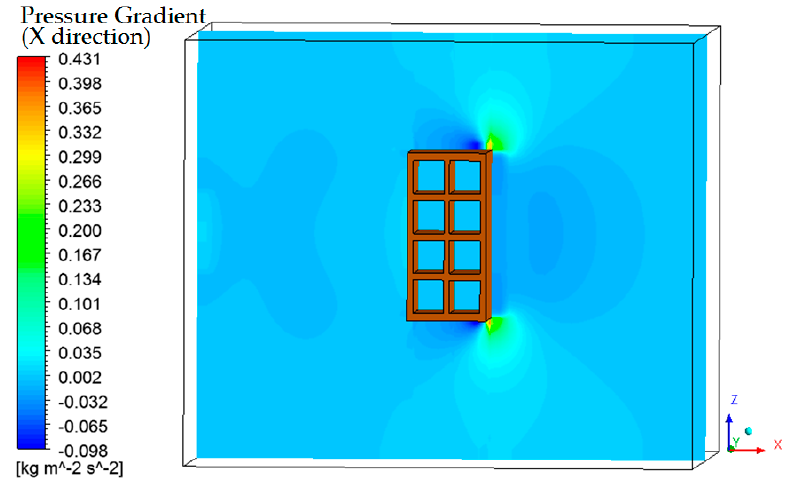
= 0.1 m) at the instant 950